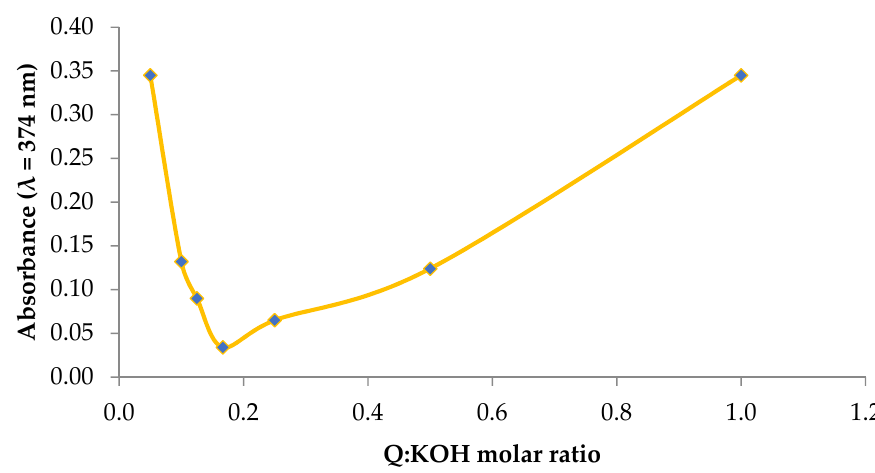
Figure 1. Determination of optimal molar ratios between reactants by Job’s method.